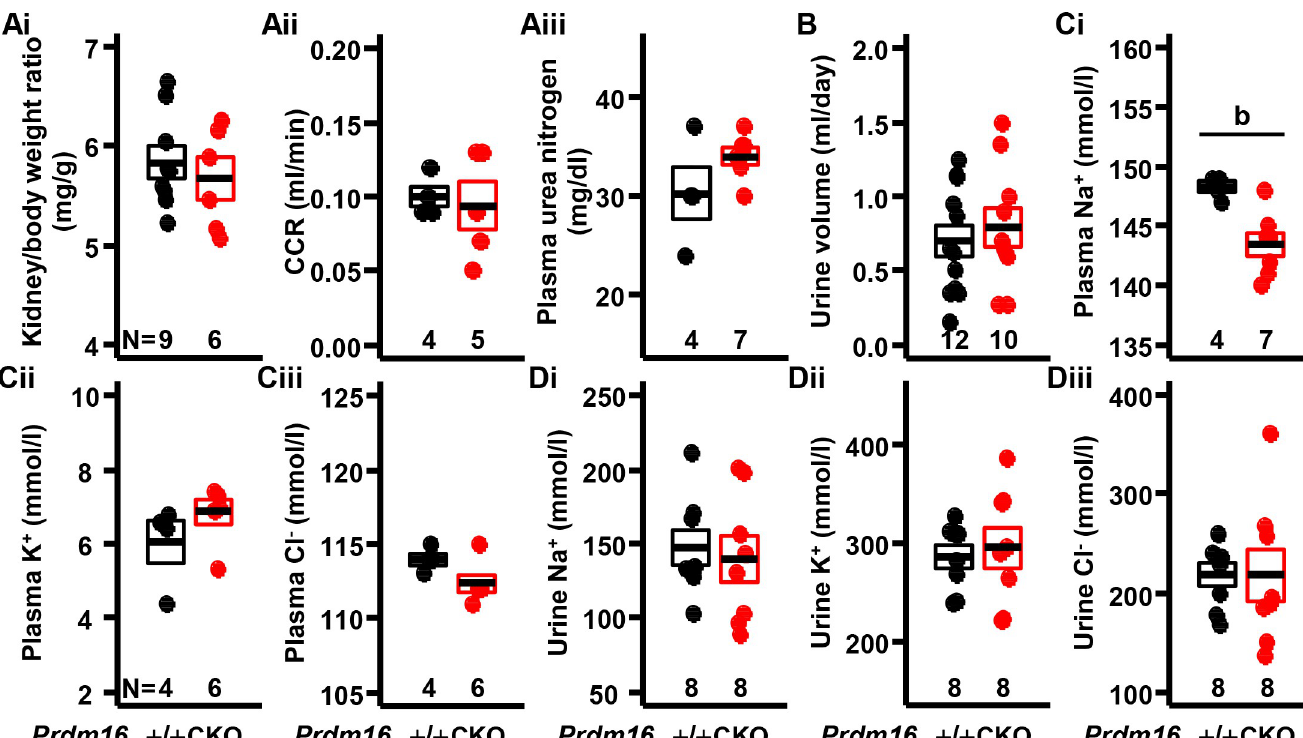
Fig 4. Changes in electrolyte balance in cardiac-specific Prdm16 knockout, female mice. (Ai) Kidney-to-body weight ratio. (Aii) Creatinine clearance rate (CCR). (Aiii) Urea nitrogen in the plasma. (B) 24-hour urine volume. (Ci) Plasma sodium levels. (Cii) Plasma potassium levels. (Ciii) Plasma chloride levels. (Di) Urinary sodium levels. (Dii) Urinary potassium levels. (Diii) Urinary chloride levels. Error bars, mean ± SEM; number (N), number of mice; statistical significance by student’s t -test, b ( P <